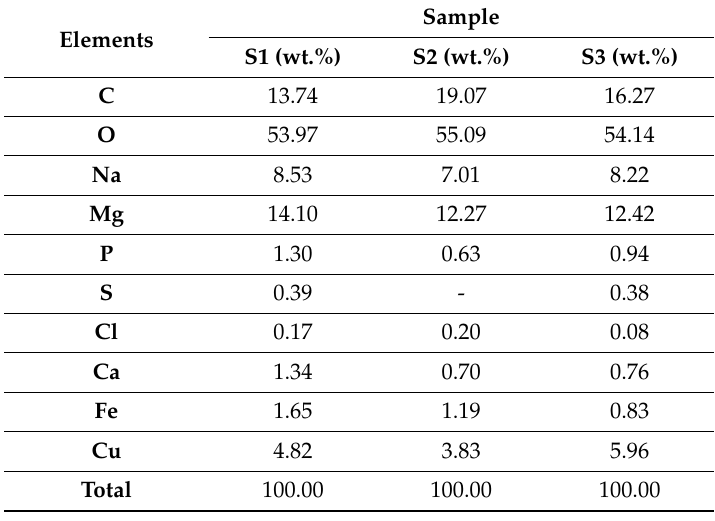
Table 1. Energy-dispersive X-ray analysis (EDX) of samples ( a ) S1, ( b ) S2, and ( c ) Table 1. Energy ‐ dispersive X ‐ ray analysis (EDX) of samples ( a ) S1, ( b ) S2, and ( c ) S3.